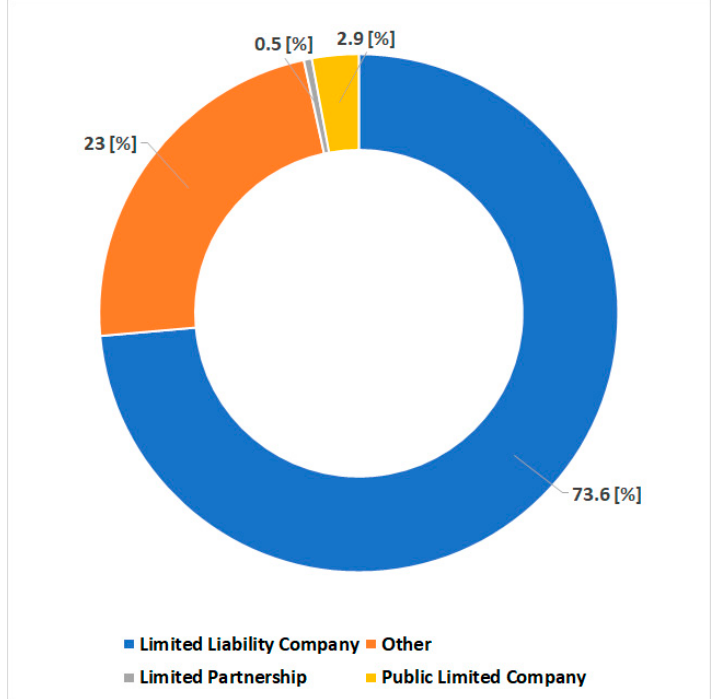
Figure 6. Distribution of the structure of businesses operating in the Podkarpackie Voivodeship by legal form of activity. Source: own elaboration based on the data analyzed from 2018 (http://www.emis.com).